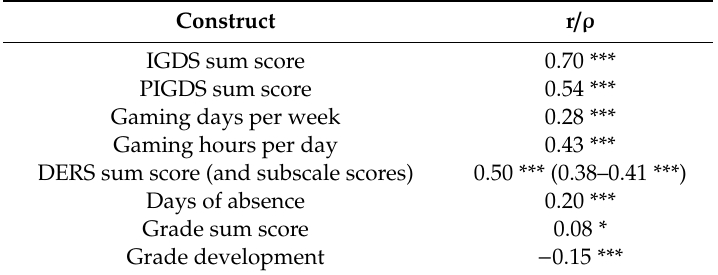
Table 3. Criterion validity—Pearson / Spearman correlations of GADIS-A sum